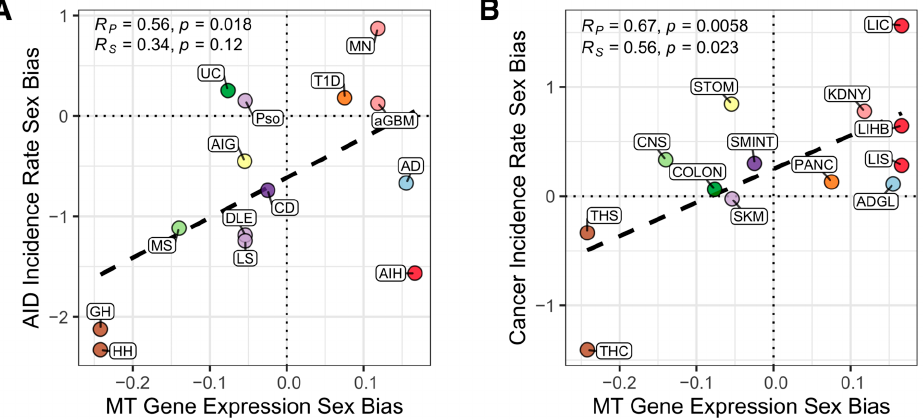
Figure 3. Mitochondrial gene expression is a strong correlate of sex biases in incidence rate of auto- immune diseases and cancer types across tissues. The correlation between expression ratio of mito- chondrial gene expression in male vs. female tissues ( x -axis) with the incidence rate sex biases of ( A ) autoimmune diseases ( y -axis) and ( B ) cancer types ( y -axis) across human tissues (circle color indi- cates the tissue). AIDs: AD, Addison’s disease; aGBM, anti-glomerular basement membrane nephri- tis; AIG, Autoimmune gastritis; AIH, Autoimmune hepatitis; CD, Celiac disease; DLE, Discoid lu- pus erythematosus; GH, Graves’ hyperthyroidism; HH, Hashimoto’s hypothyroidism; LS, Local- ized scleroderma; MN, primary autoimmune membranous nephritis; MS, Multiple sclerosis; Pso, Psoriasis; T1D, Type 1 diabetes; UC, Ulcerative colitis. Cancers: ADGL, adrenal gland cancer; CNS, central nervous system cancer; COLON, colon cancer; KDNY, kidney cancer; LIC, liver carcinoma; LIHB, liver hepatoblastoma; LIS, liver sarcoma; PANC, pancreatic cancer; SMINT, small intestine cancer; SKM, skin melanoma; STOM, stomach cancer; THC, thyroid carcinoma; THS, thyroid sar- coma.